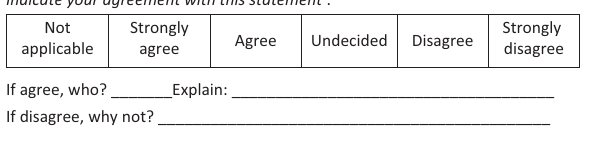
People explained which sec(cid:16)ons of mathema(cid:16)cs would help me in accoun(cid:16)ng. Indicate your agreement with this statement : Not applicable